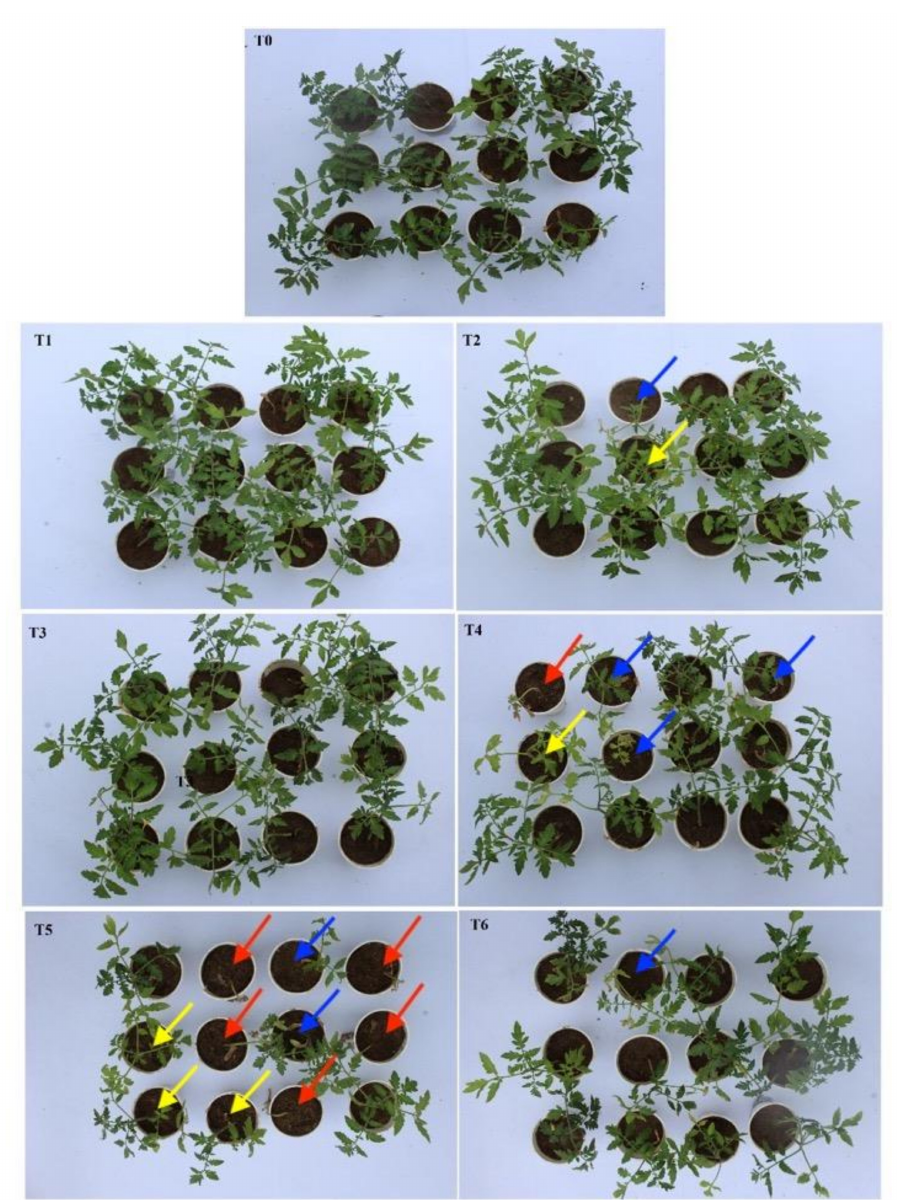
Figure 5. Representative photograph of each treatment showing the growth and e ff ects of FORL. T0 = control (10% w / v sterile SOA); T1 = plant pre-treated with the endospore-forming bacteria (EFB) and placed in 10% w / v sterile SOA; T2 = plant pre-treated with the EFB 24 h before infection with FORL and placed in 10% w / v sterile SOA; T3 = plants placed in 10% w / v mixture without sterilization SOA; T4 = plants infected with FORL and placed in 10% mixture without sterilization SOA; T5 = plants infected with FORL and placed in 10% sterile SOA; T6 = plants pre-treated with carbendazim (Goldazim 500 SC TM ) (50 mL / 100 L) 24 h before infection with FORL and placed in 10% sterile SOA. Red arrows indicate severity index 4. Blue arrows indicate severity index 3. Yellow arrows indicate severity index 2. Plants without arrows indicate severity index